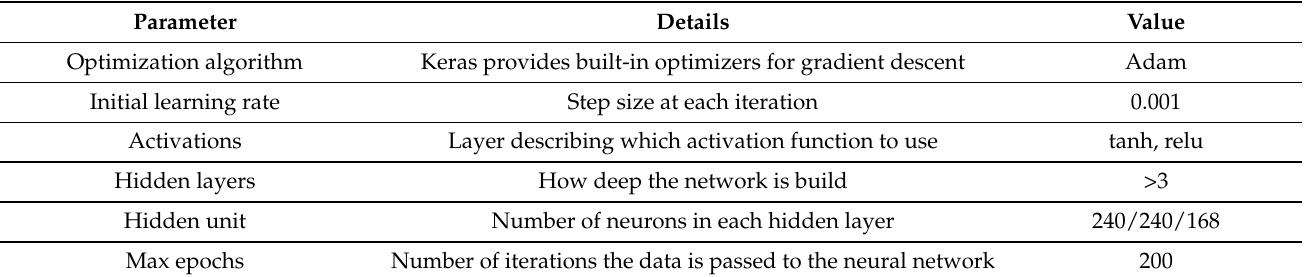
Table 3. LSTM model